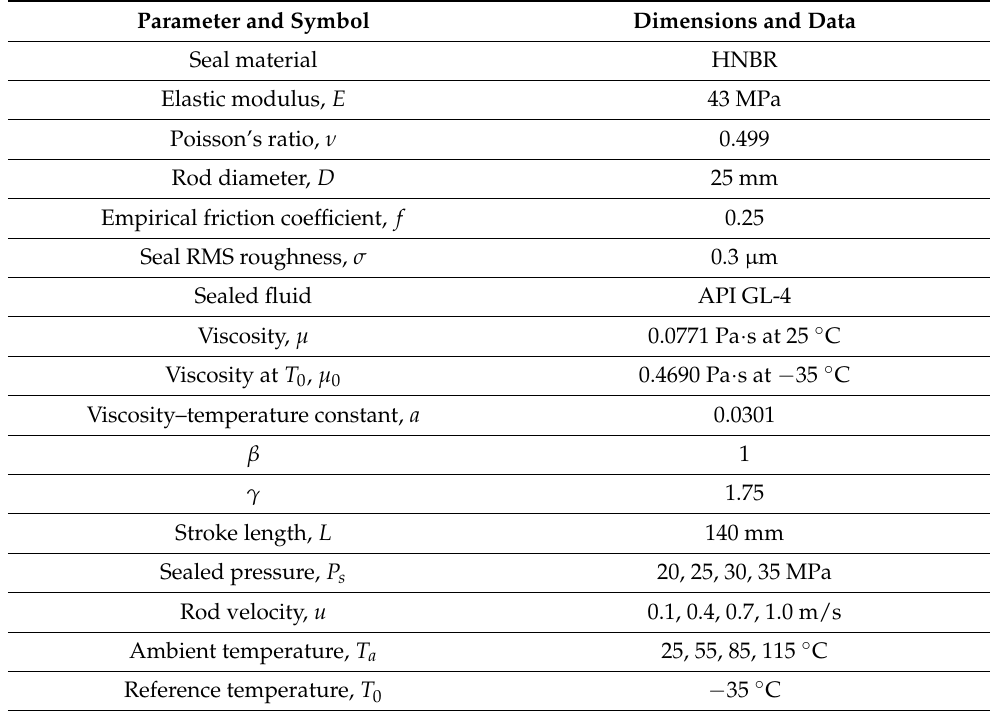
Table 1. Parameters of the numerical